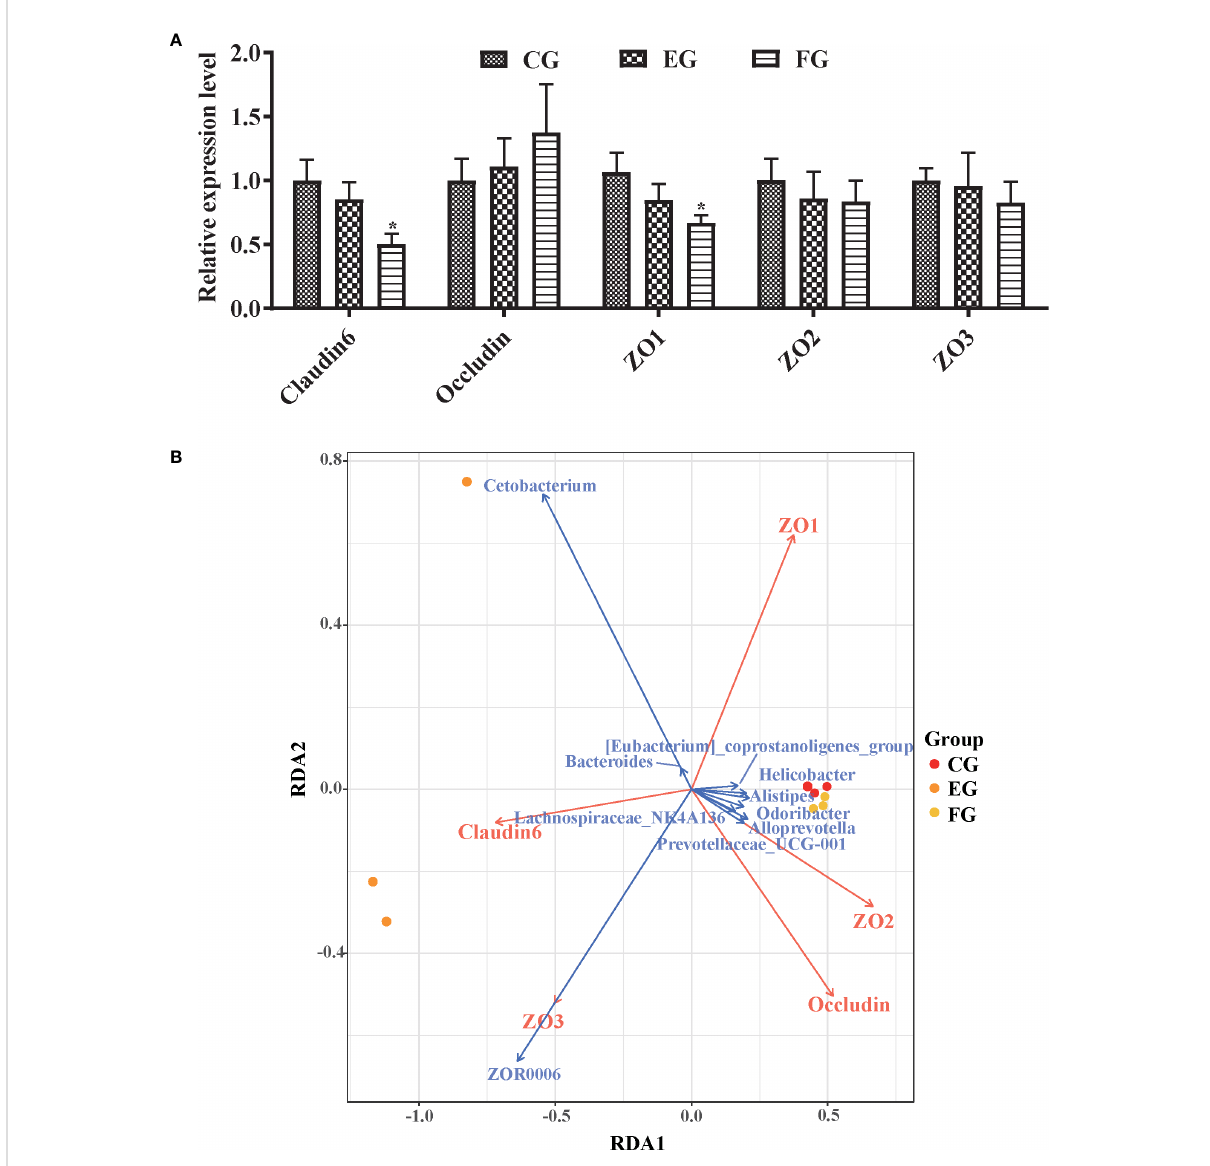
FIGURE 7 Relative expression levels of tight junction protein genes associated with the core microbiomes. (A) Immune genes expression level of tight junction proteins Claudin6 , Occludin , ZO-1 , ZO-2 , and ZO-3 mRNA in the midgut of grass carp fed with the control and antibiotic diets for 2 weeks via qRT-PCR. The different symbols show signi fi cant differences (*, p < 0.05). (B) RDA pro fi le of the correlation between tight junction proteins (red arrows) and key genera (blue arrows) in the midgut of grass carp fed with control, enro fl oxacin and fl orfenicol